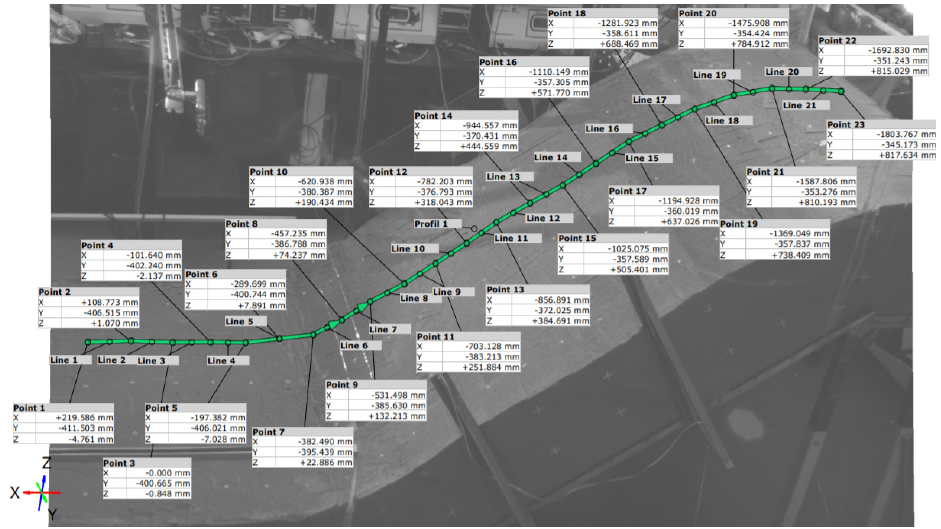
Figure 9. 3D view of the reference undeformed image—Stage 1 [66]. Changes of x , y , and z coordinates, i.e., displacements, are measured by comparison with the position of the recognized reference points through consecutive images that cor- respond to different degrees of deformation (stages through time). Since the whole test was recorded in the sequence of 479 images, a few characteristic stages of the recorded test were chosen and presented for the visible points. Besides the initial stage (Stage 1), two other stages were chosen because of the visibility of points and the biggest displace- ments happening around that time—stage 330 and stage 434. Comparing the reference undeformed image from stage 1 to stage 330 visible in Figure 10 which was recorded at the moment of formation of the crack at the bottom of the middle part of the model, on the edge of the point 13. Here, all points before number 13 are lost in the sliding of the mass or covered by the water level that formed at the foot of the slope. Further, points 15 and 16 are not visible above, probably due to the poor lighting and creation of a shadow above the aforementioned points. At the top of the model, on the horizontal part of the line, point 23 cannot be defined. The possible reason could be the reduced visibility of the point by retaining water droplets on it and/or the position of the point being too close to the plexiglass. Figure 10. 3D view of the analyzed stages of the longitudinal profile—Stage 330 [66].